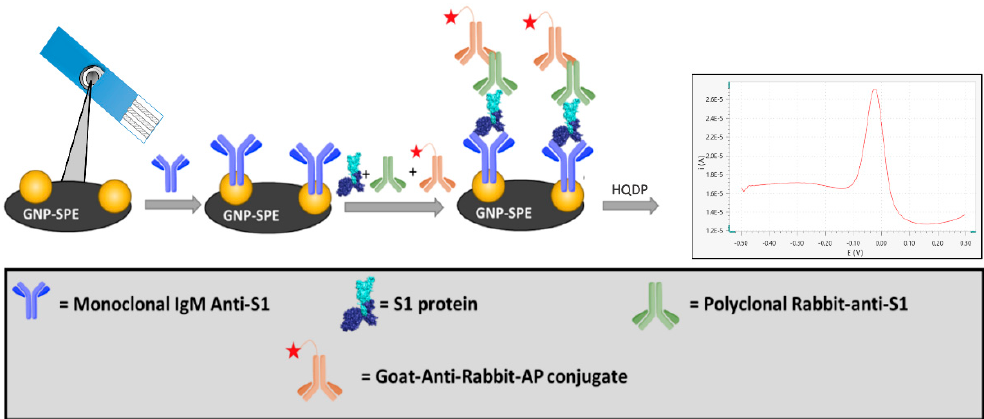
monoclonal antibody as a receptor (capture antibody), an anti-S1 polyclonal antibody, and an alkaline phosphatase-conjugated secondary antibody as reading antibodies (Figure 1).